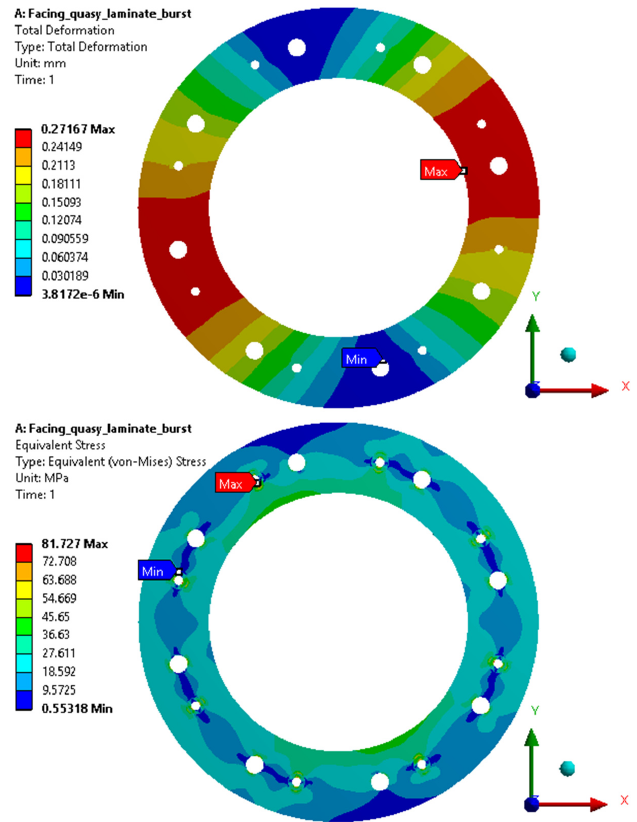
Figure A4. Total deformation and equivalent von Mises stress distribution of the composite facing.